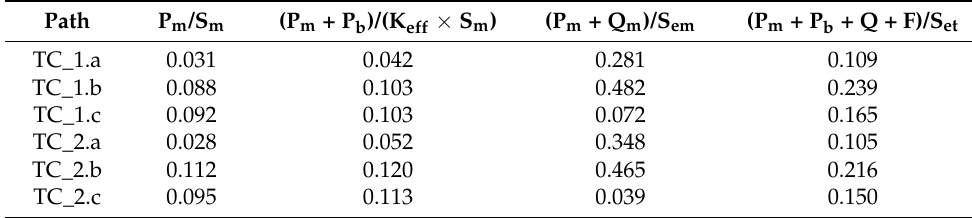
Table 10. RCC-MRx Level A criteria verification within TC domain.